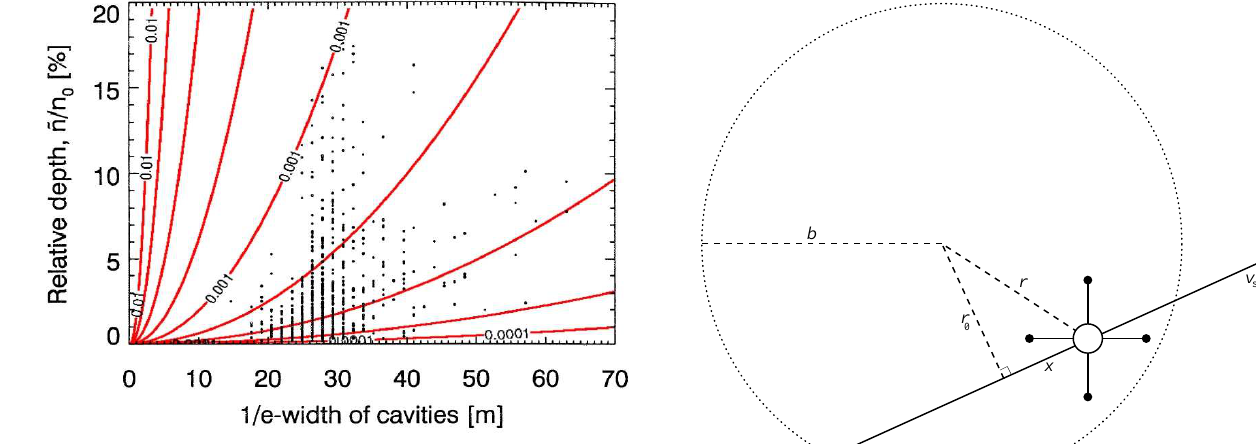
Fig. 3. Scatter plot of the measured 1 /e -widths and depths of 672 cavities from orbit 1234 of the Freja satellite. Data are taken from Høymork et al. (2000). We have superimposed contours of the maximum values of k z (unitm − 1 ) in red, for given width and depth of a cavity according to Eq. (41). The parameters used are m = 1, f LH = 2100Hz and f ce = 8 . 4 × 10 5 Hz. The relative depth cor- responds to the parameter 1 in Eq. (41) and the 1 /e -width to b in the same equation. Underlying dataplot reproduced by permission of the American Geophysical Union.